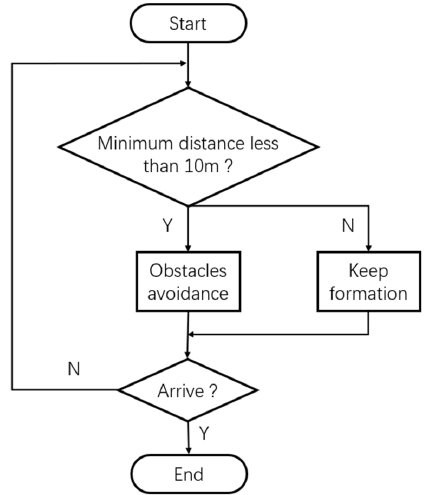
Figure 14. Four-vehicle communication topology diagram.